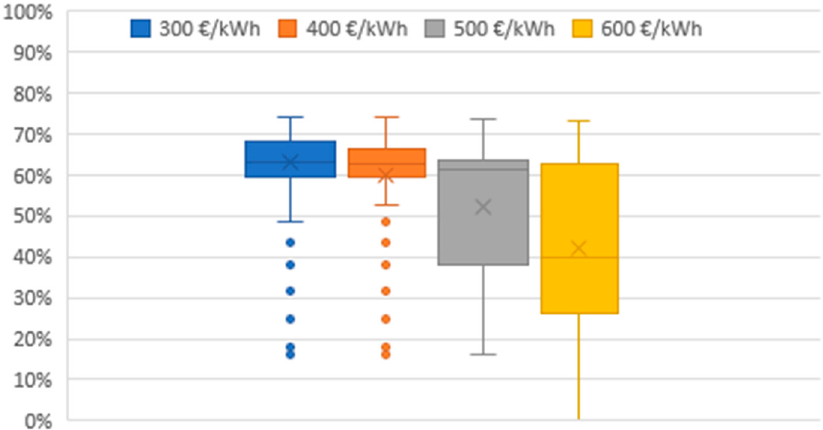
Figure 20. Box and whisker plot of the percentage of the electrical overproduction with respect to the total electricity production, depending on the ES unitary cost.